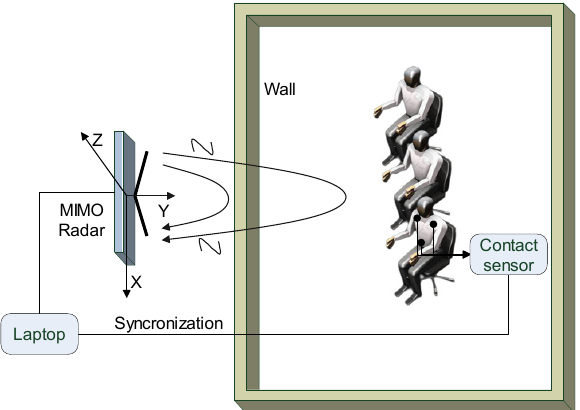
Figure 4. Schematic diagram of through-wall multi-subject vital signs measurement.